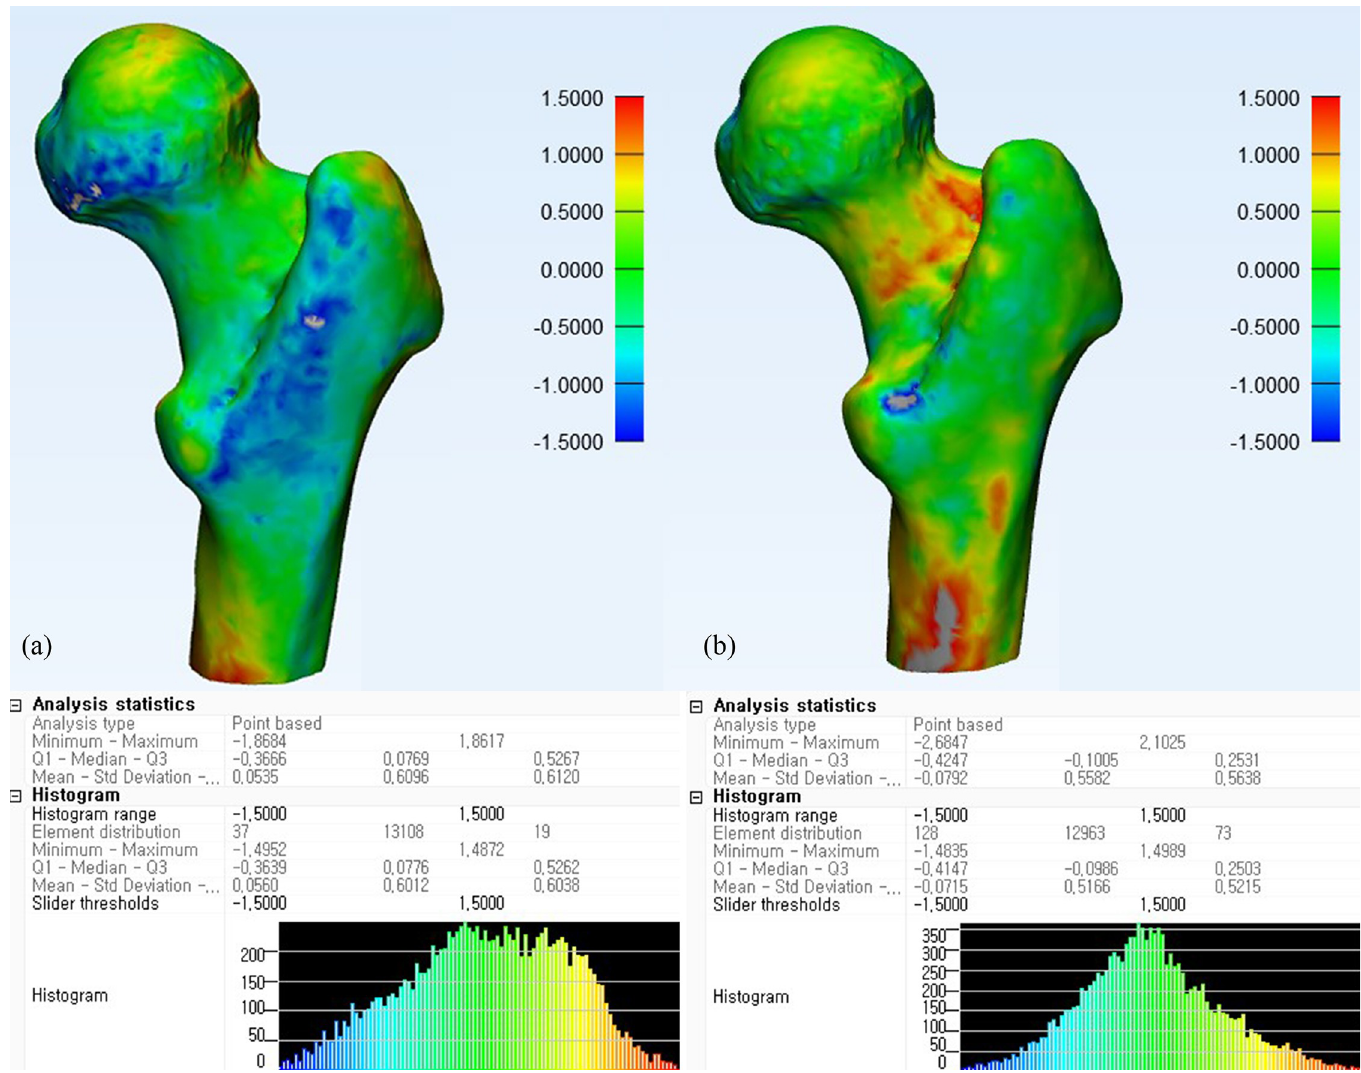
Fig 3. Difference map between 3D-MRI models and CT of a proximal femur. Difference maps of a 20-year-old female proximal femur with normal osseous anatomy using Dixon (a) and water excitation methods (b).